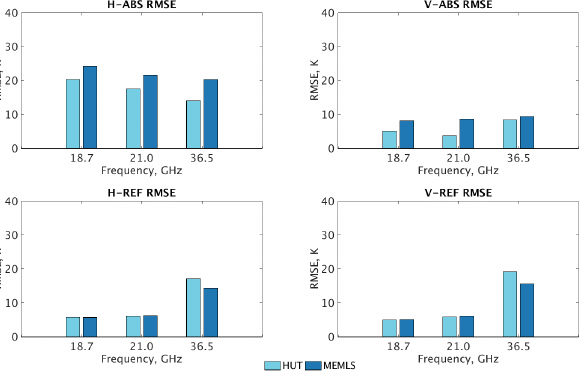
Figure 6. Simulated brightness temperature bias at horizontal (H) and vertical (V) polarizations for the absorber material base (ABS) and the reflective metal plate base (REF). Eight slabs were sim- ulated at 18.7 and 21.0GHz, while seven slabs were simulated at